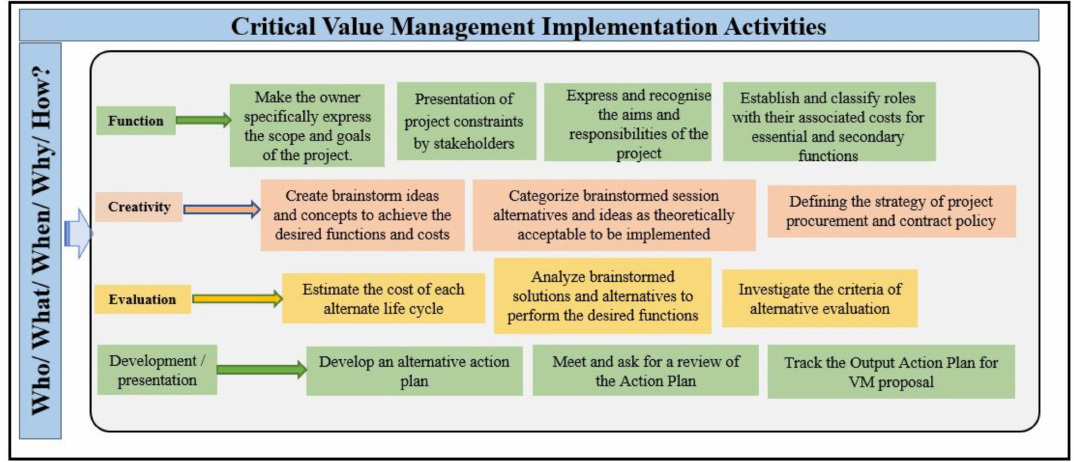
Figure 12. Critical VM activities